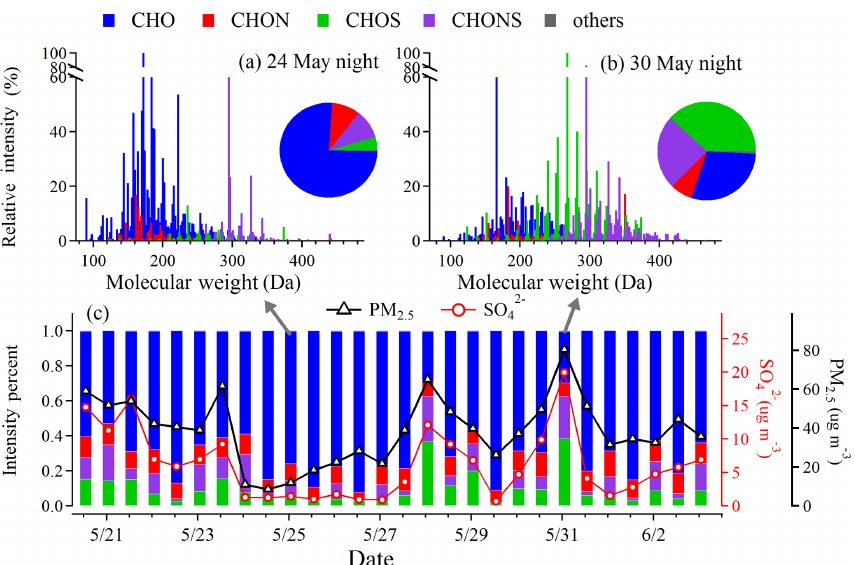
Figure 1. The intensity distribution of different compound categories (CHO, CHON, CHOS, and CHONS) (a) on a clean day and (b) on a polluted day. (c) Temporal variation in PM 2 . 5 , SO 2 − , and intensity percentages of different compound categories. The highly water-soluble 4 OS species (e.g., isoprene OSs) with lower MW are absent in these figures and details are described in Sect.